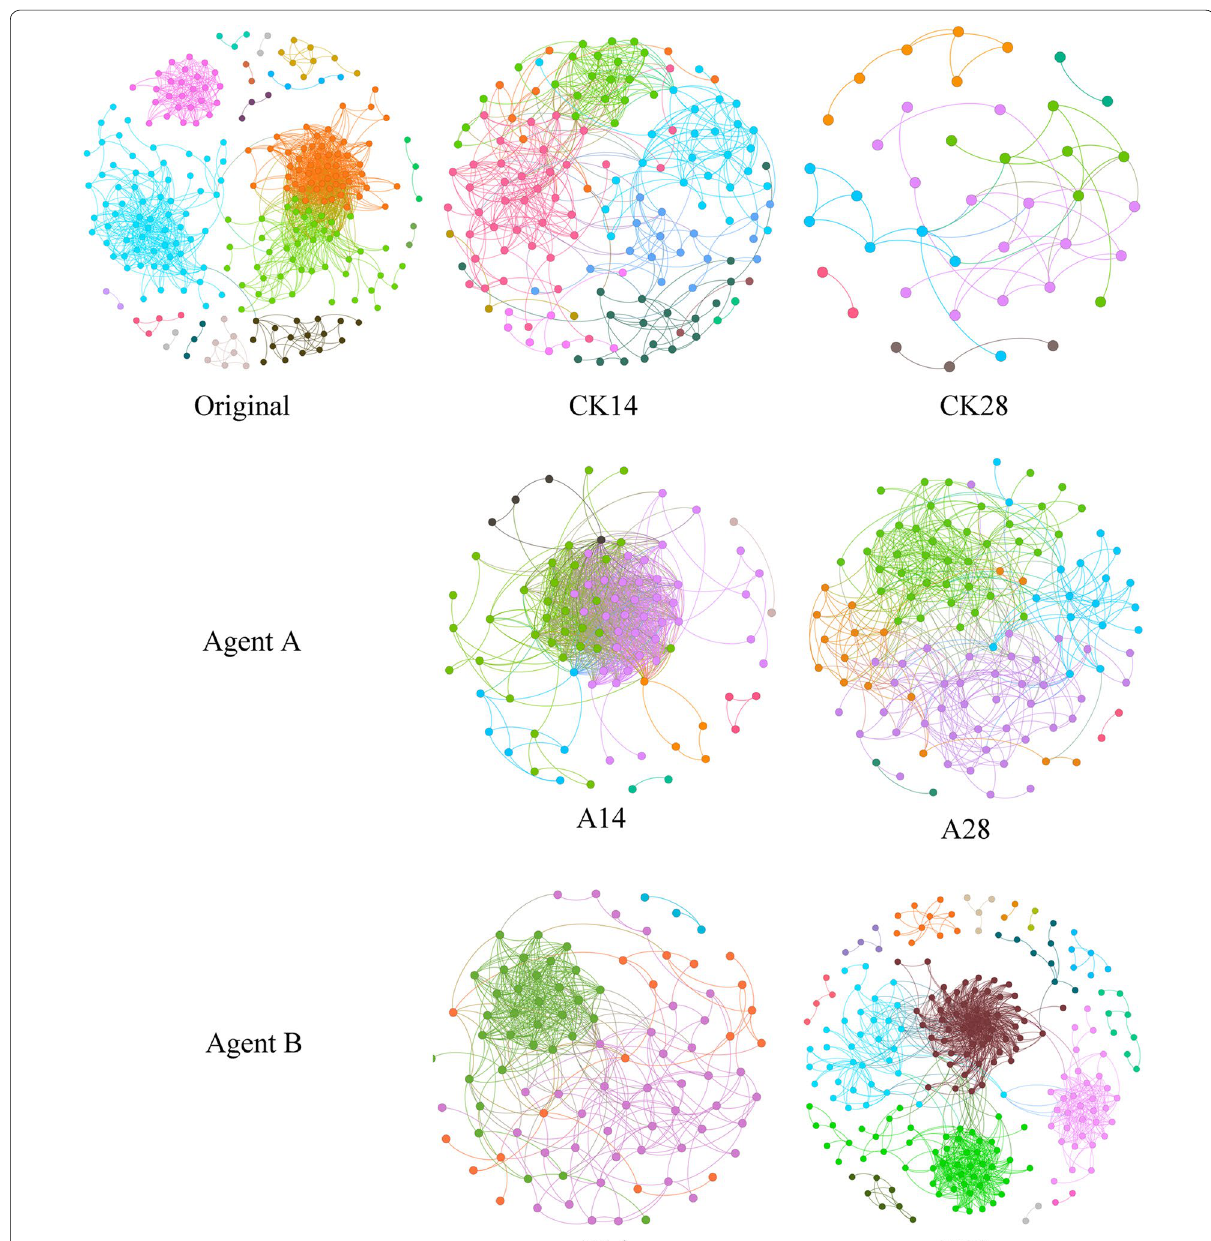
Fig. 5 Random matrix theory (RMT) based molecular ecology network. Networks represent random matrix theory models derived from 8 biological replicates in each cropping system. Each node represents an OTU. The links between the nodes indicate strong and significant ( p < 0.01)